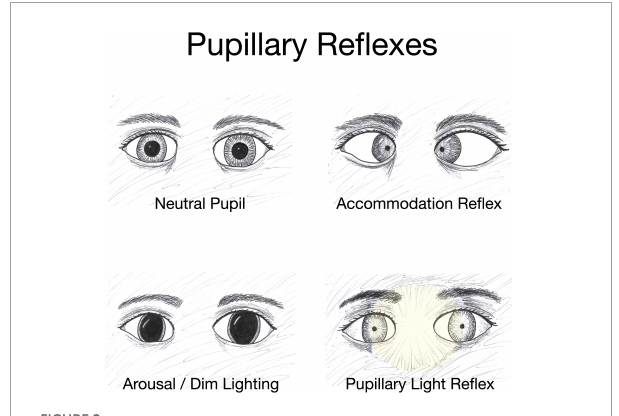
FIGURE2 Pupillary reflexes. The diameter of the pupil changes in response to specific conditions such as variations in object distance and level of illumination. The accommodation reflex, an adjustment for near vision, results in pupillary constriction, and inward rotation of the eyes as an object draws nearer. Dim lighting elicits pupillary dilation as does emotional arousal. Increased brightness of lighting causes pupillary constriction and the effect is both direct (affecting the eye exposed to the light) and consensual with constriction of the pupil in the eye opposite to the light-stimulated